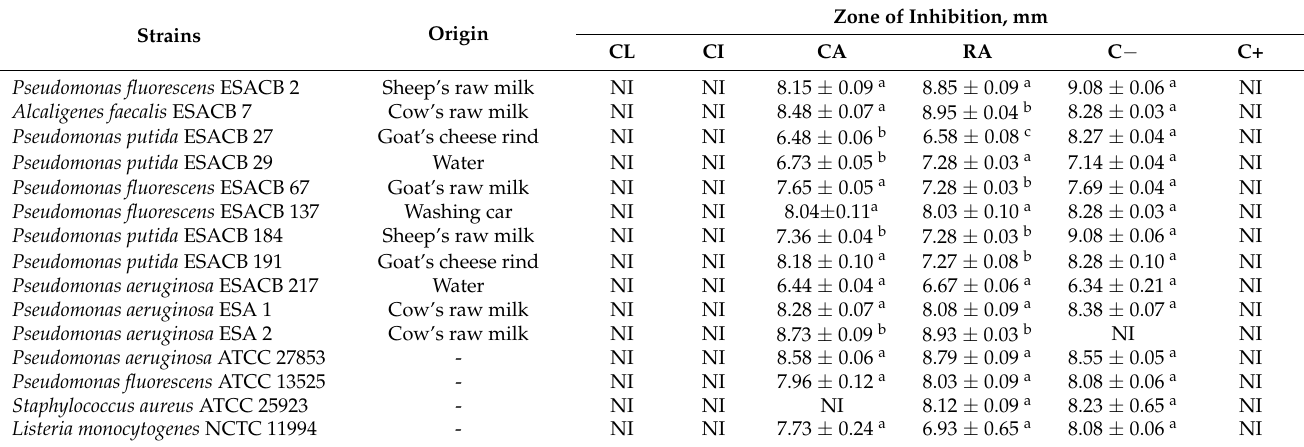
Table 2. Antimicrobial activity of C. cardunculus extracts measured by the inhibition zone (mm)